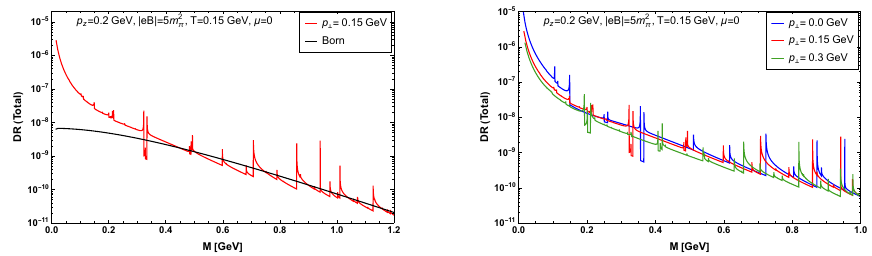
Figure 5. Plot of rate as a function of invariant mass for di ff erent values of the transverse momentum.